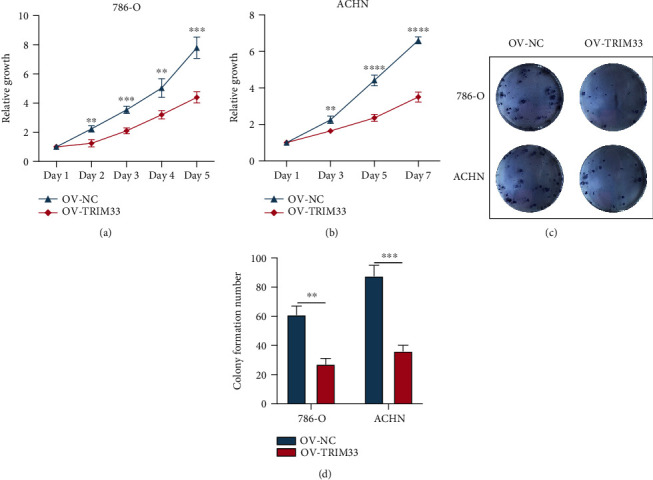
Cell proliferation experiment in vitro. (a and b) CCK-8 assay. The OD values of the OV-TRIM33 group and the OV-NC group in 786-O cells and ACHN cells were measured by the CCK-8 assay, and the relative growth rate of each group was evaluated. (c and d) Colony formation assay. Image-Pro Plus software was used to calculate the number of colonies formed. ∗∗P < 0.01; ∗∗∗P < 0.001; ∗∗∗∗P < 0.0001.